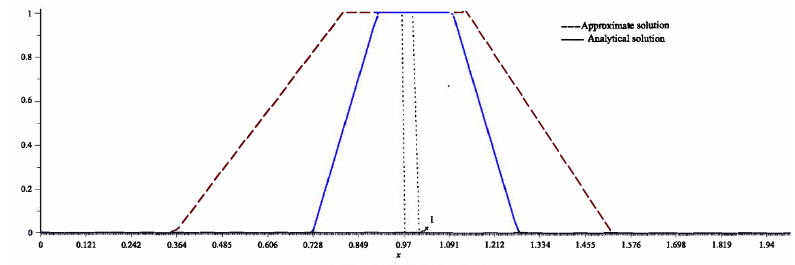
Figure 3. Approximate and analytical solutions of Example 3.